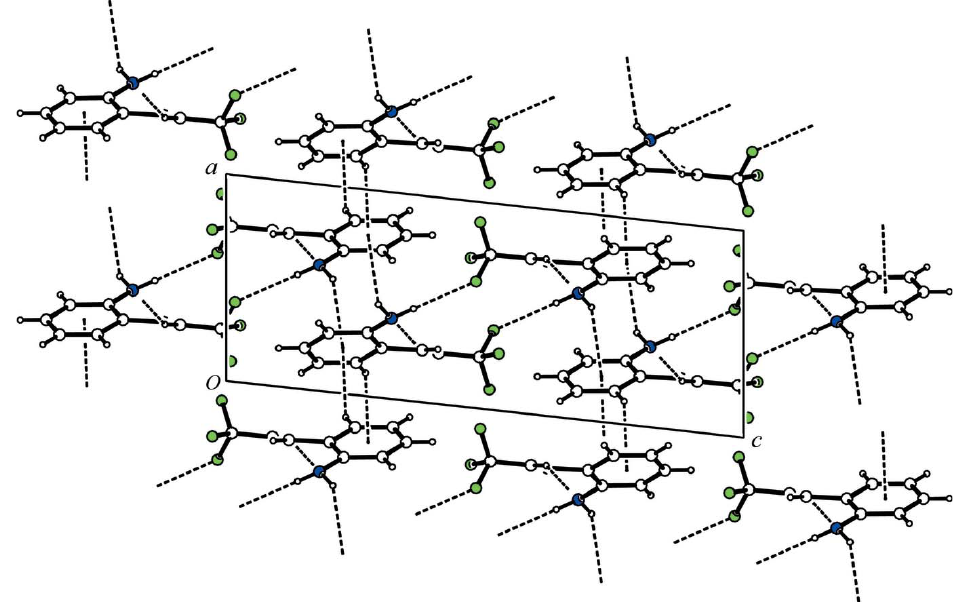
Figure 2 A packing diagram of the title compound, viewed along the b axis. The N—H (cid:3)(cid:3)(cid:3) F and C—H (cid:3)(cid:3)(cid:3) N hydrogen bonds and N—H (cid:3)(cid:3)(cid:3) (cid:2) and C—H (cid:3)(cid:3)(cid:3) (cid:2) interactions are shown as dashed lines.